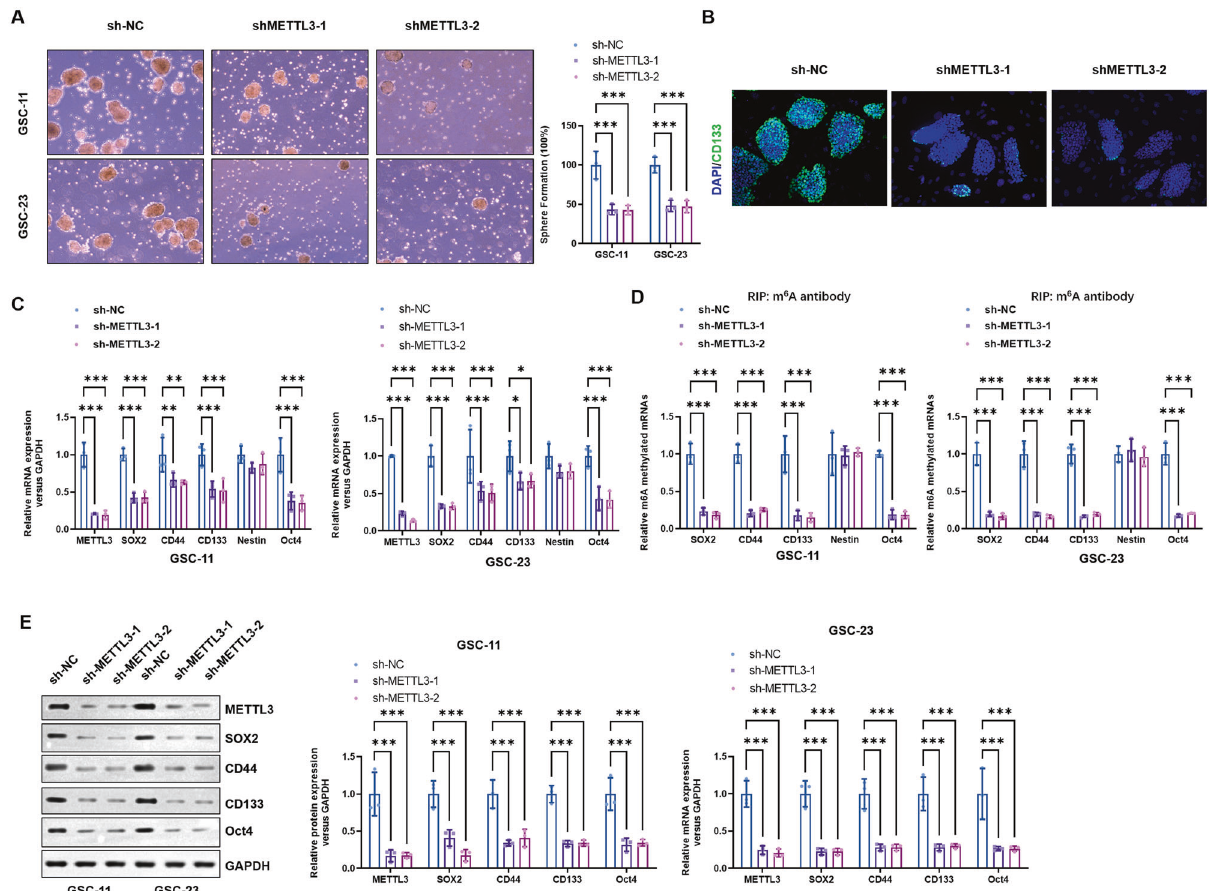
Fig. 2 METTL3 knockdown impaired self-renew and stemness maintenance of GSCs. A METTL3 knockdown signi fi cantly decreased the number of tumorspheres formed by GSC-11 and GSC-23 cells in vitro. B IF analysis was performed to evaluate the effect of METTL3 knockdown on CD133 expression of GSC-11 cells. C Real-time PCR was performed to detect the effect of METTL3 knockdown on the mRNA levels of several stemness markers. D Me-RIP-PCR was applied to detect the m6A methylation levels of SOX2, CD44, CD133, Nestin and Oct4 in GSCs after METTL3 knockdown. E The effects of METTL3 knockdown on the protein levels of several GSCs markers were detected by Western blotting. * P < 0.05, ** P < 0.01, *** P < 0.001 versus indicated